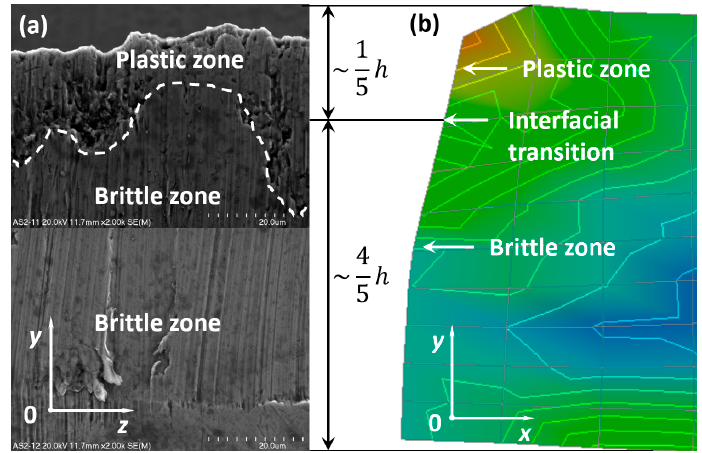
Figure 11. Comparison of the experimental ( a ) and numerical results ( b ) for the bottom sheet in a bundle.